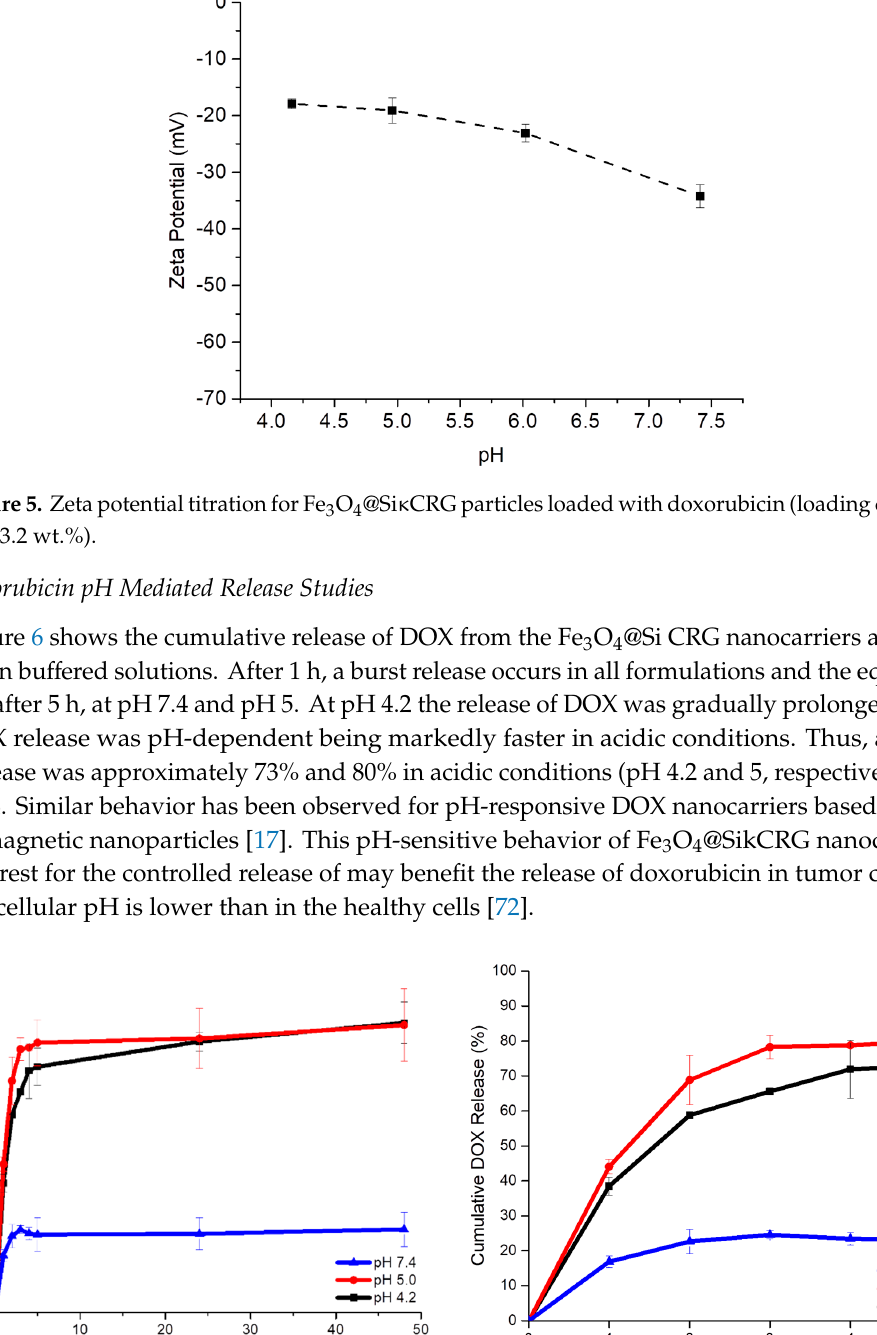
(loading capacity was 12.3 wt.%). Full profile for 48 h ( left ) and first 5 h ( right ).